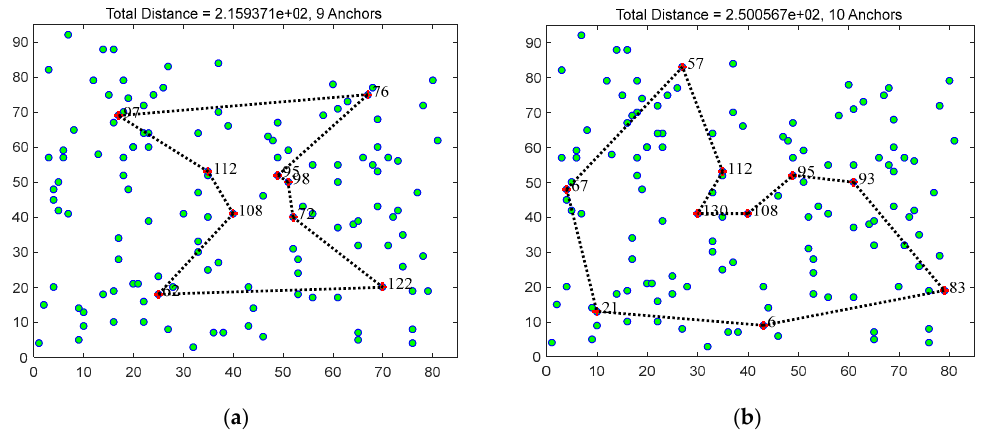
Figure 3. An example of anchor selections with 130 nodes under different touring bound L b : ( a ) the total distance is 251 m and 9 nodes are chosen to be anchors with threshold L b = 250 m; and ( b ) there are 10 anchors and the shortest tour length is 250 m with threshold L b = 300 m.